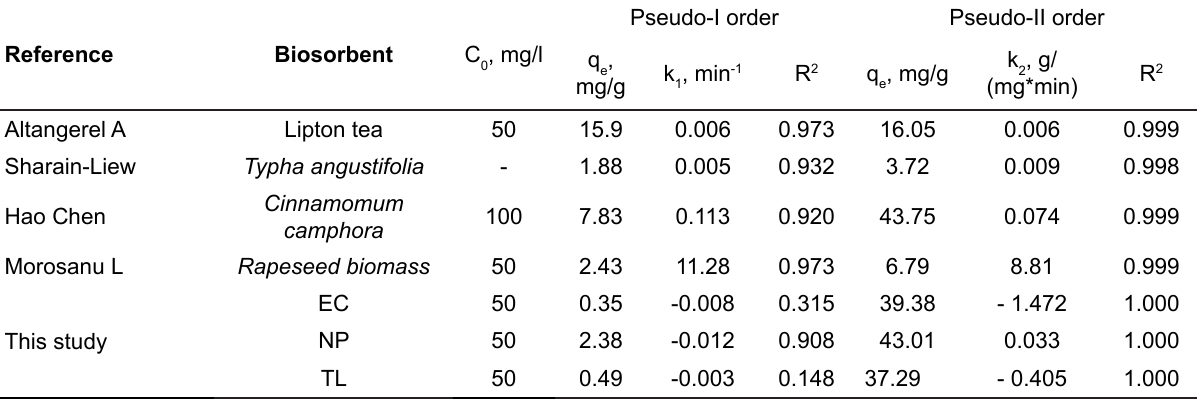
Table 5. Pseudo first and second order kinetic constants compared to reference studies